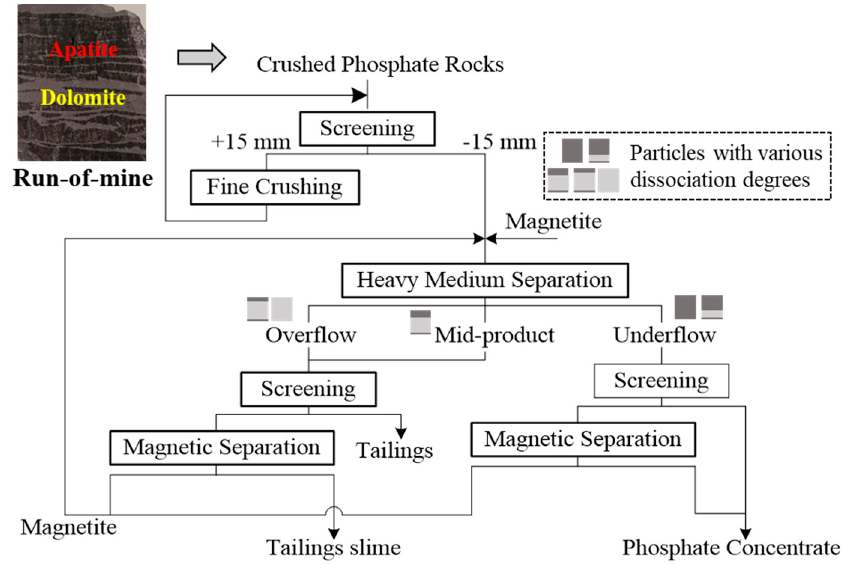
Figure 4. Schematic flowsheet of gravity separation for sedimentary phosphate rock characterized by a strip structure. strip